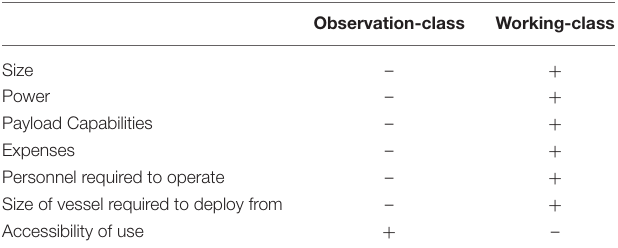
TABLE 1 | General differences in capabilities between observation-class and working-class ROV systems, with “–” signifying qualities that are less/fewer than and “ + ” signifying qualities that are more/greater